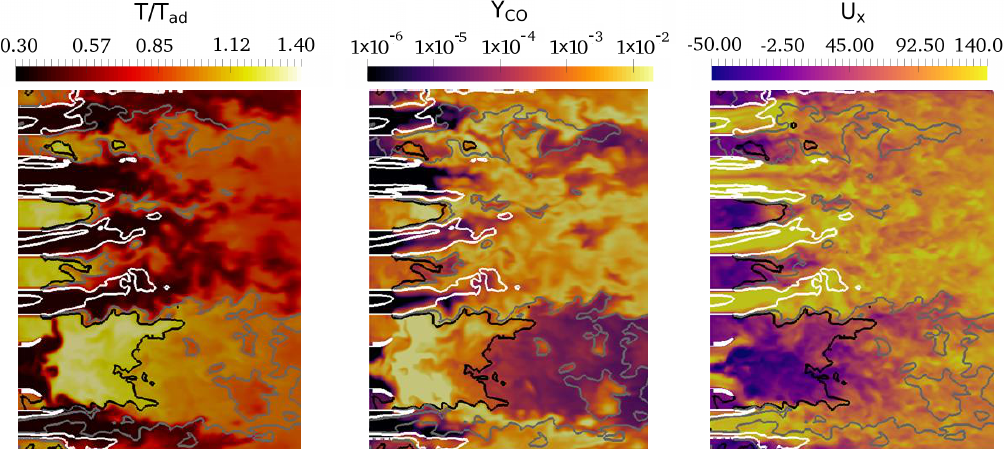
Figure 3. Instantaneous contours of normalized temperature ( left ), carbon monoxide mass fraction ( mid ) and axial velocity ( right ) in the combustion chamber mid-plane with equivalence ratio iso-lines for Φ = 0.3 (white), Φ = 0.5 (gray) and Φ = 0.7